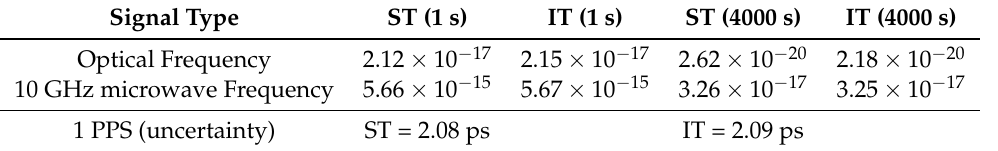
Table 1. A comparison of the simultaneous transfer and independent